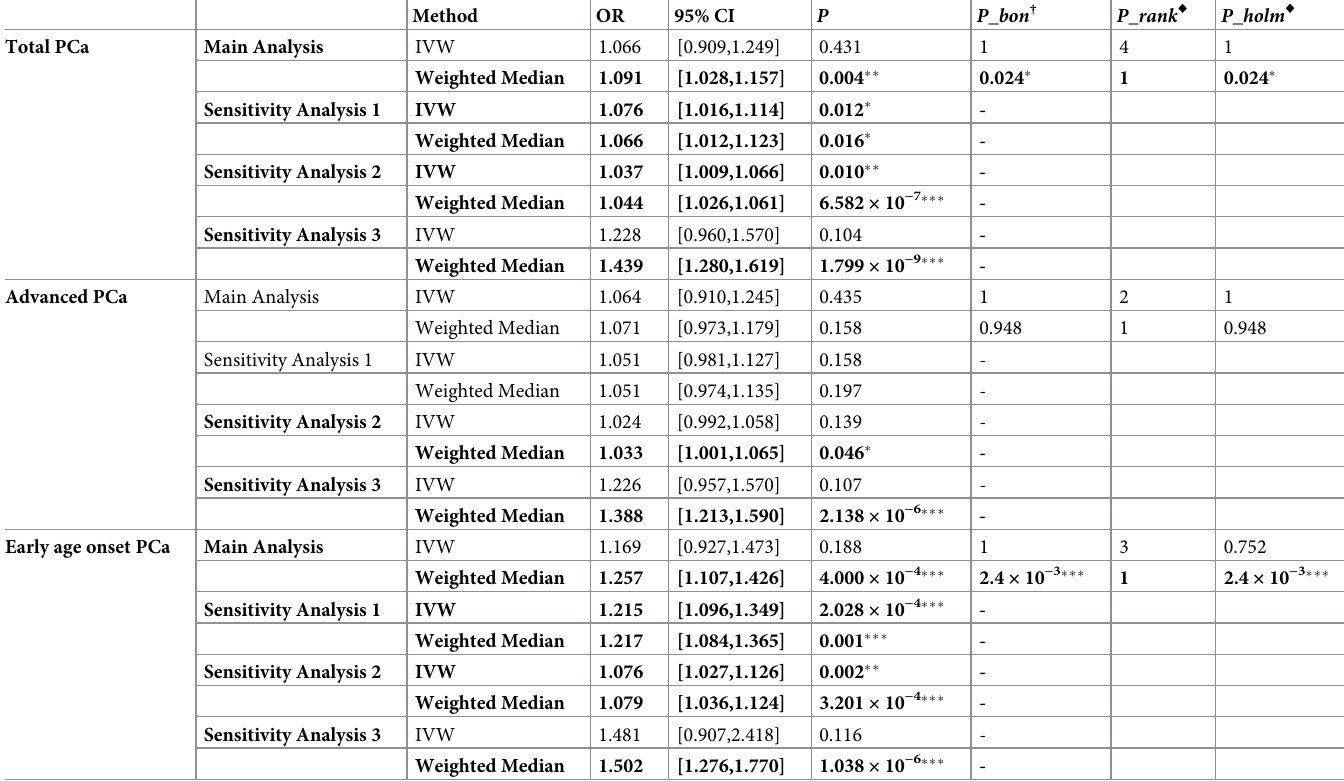
Table 1. Univariable estimates of genetically predicted Lp(a) on each PCa